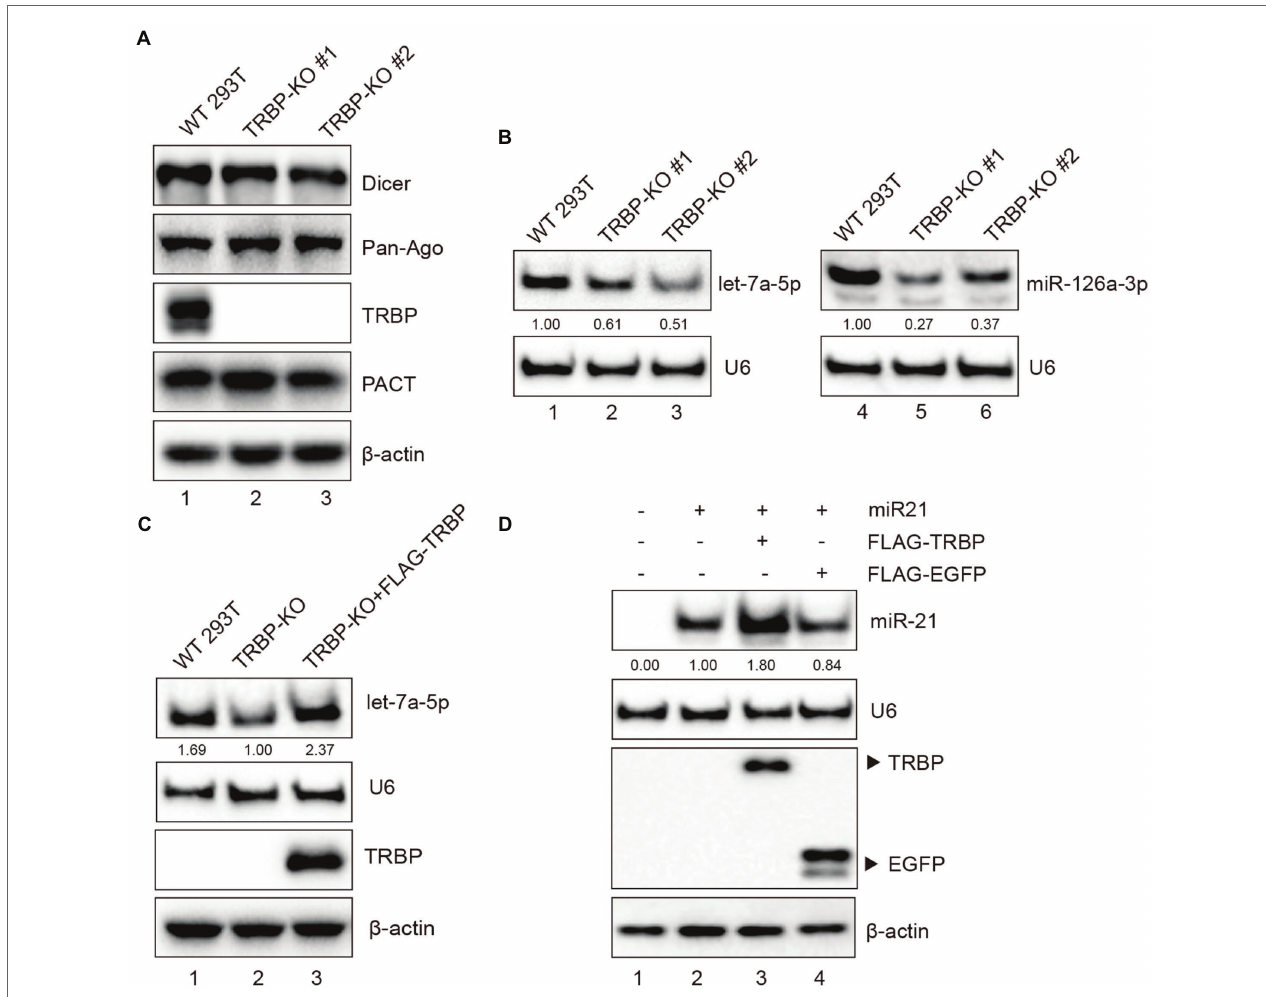
FIGURE 5 | TRBP affects miRNAs production. (A) RISC-associated proteins of 293 T and TRBP-KO cells were detected by Western blotting. (B) Northern blotting analysis of miR-126a-3p and let-7a-5p expression levels in the indicated cells. The relative expression levels of miRNAs are normalized to that of U6 small nuclear RNA and to the miRNA level from the WT 293 T cells. (C) TRBP promotes endogenous let-7a-5p expression. FLAG-TRBP was transfected into TRBP-KO cells for 48 h. Northern blotting and Western blotting were performed to detect let-7a-5p, U6, TRBP, and β -actin expressions in the indicated cells. The relative expression level of let-7a-5p is normalized to that of U6 small nuclear RNA and to the miRNA level from the TRBP-KO cells. (D) TRBP promotes exogenous miR-21 expression. TRBP-KO cells were transfected with a miR-21 expressing plasmid and FLAG-TRBP or FLAG-EGFP for 48 h. Northern blotting and Western blotting were performed to detect expression levels of miR-21, U6, FLAG-tagged proteins and β -actin. The relative expression level of miR-21 is normalized to that of U6 small nuclear RNA and to the miRNA level from the miR-21-transfected TRBP-KO